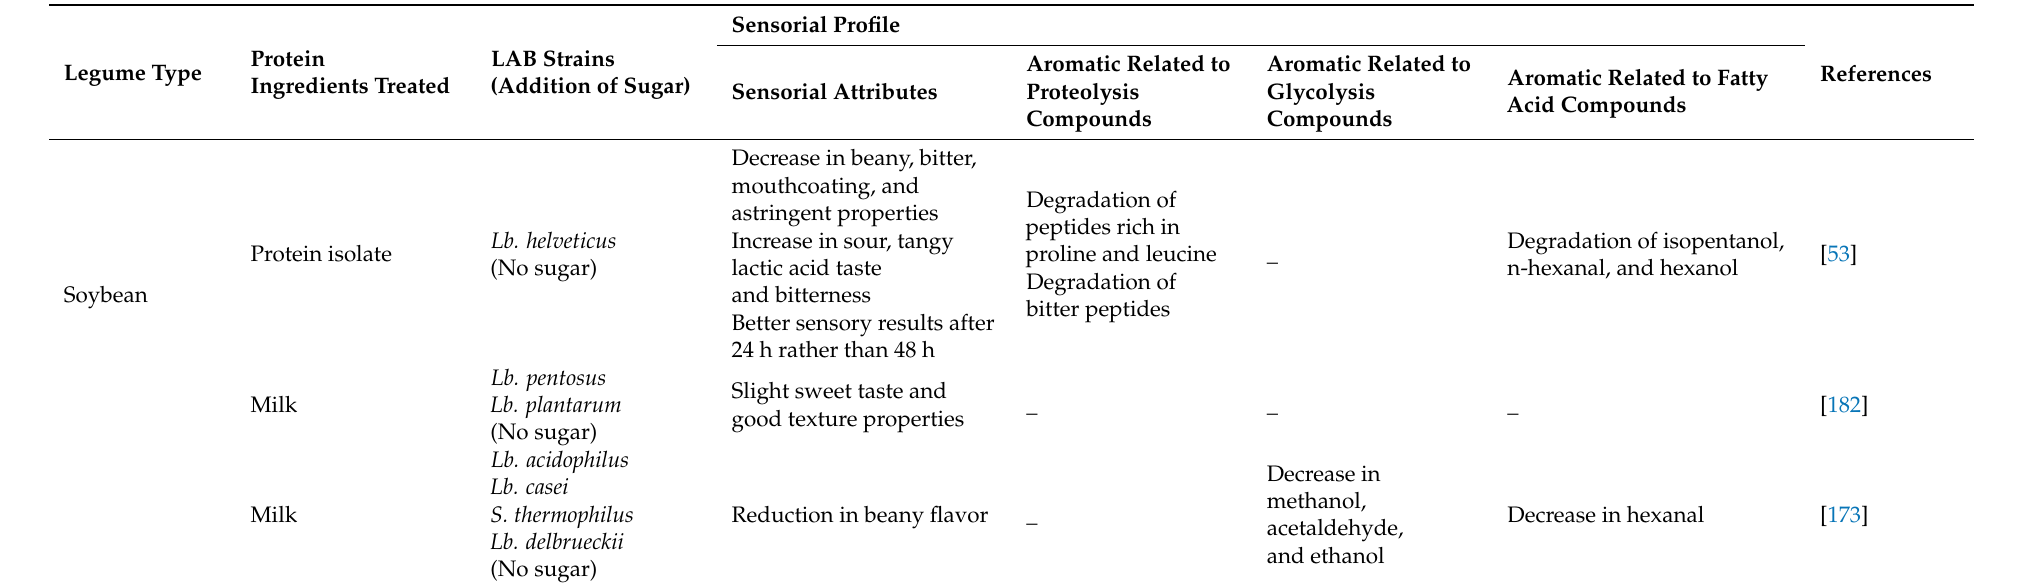
Table 3. The effects of lactic acid fermentation on sensorial properties of legume